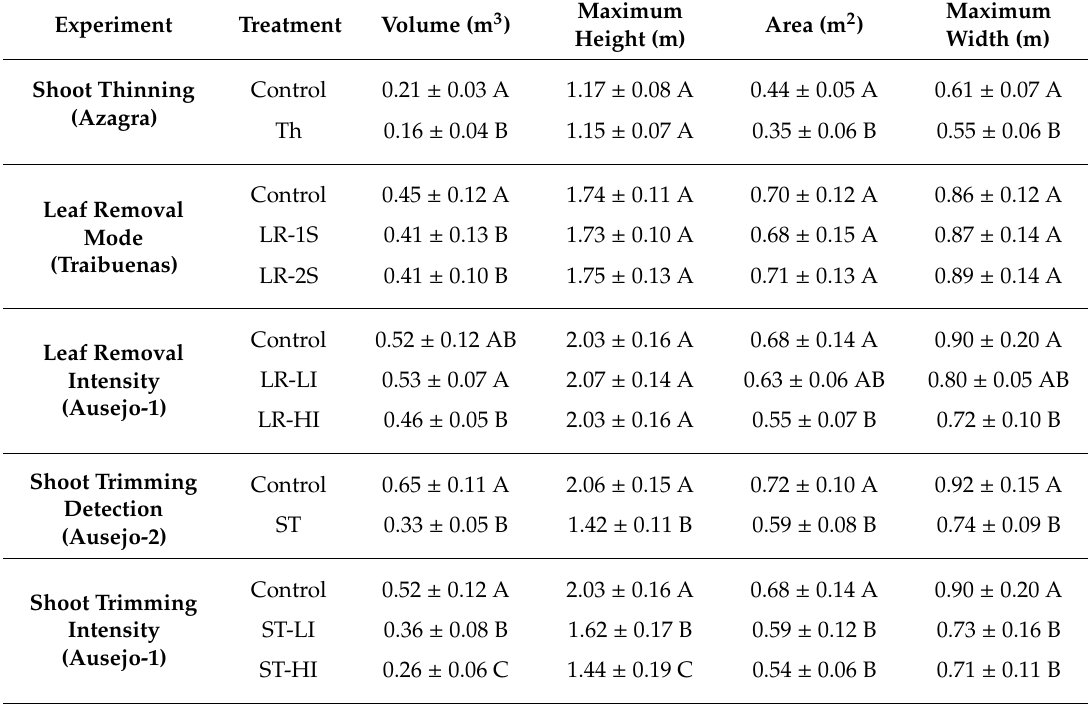
Table 7. Mean and standard deviation of vine dimensions after the canopy management operations. For each experiment and vine dimension, values followed by di ff erent letter are statistically di ff erent at p = 0.05 by a Student’s T -test.